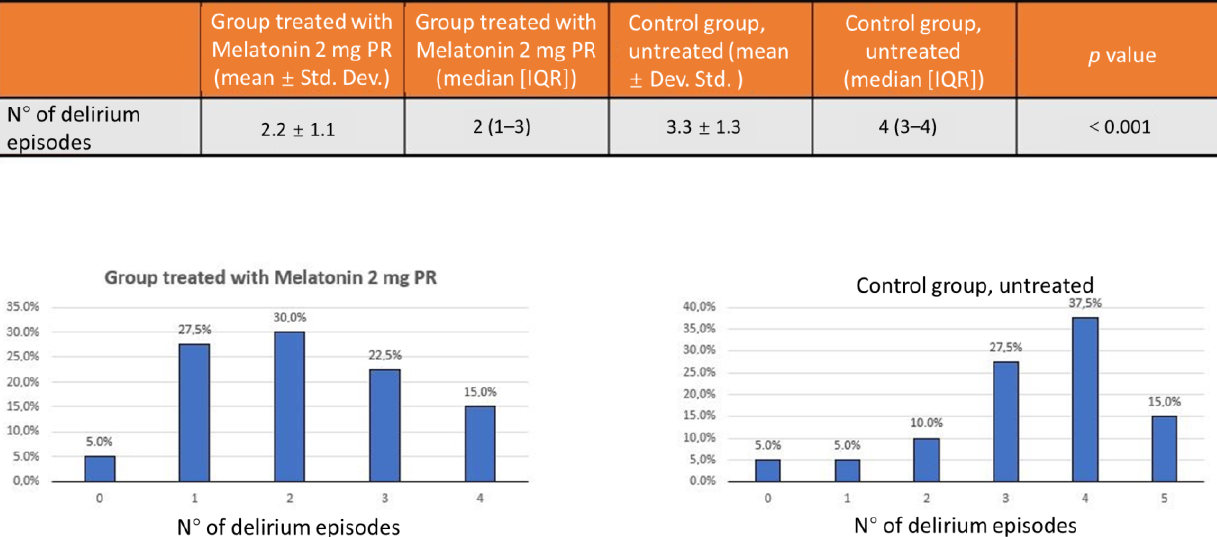
Figure 4. Number of patients transferred from sub-intensive to intensive care: in the group treated with PRM 2 mg, only 7.5% (figure 4a) versus 15% (figure 4c) of the un-treated group were transferred to intensive care due to clinical worsening, and 15% of the untreated group (figure 4d) died versus 7.5% of the treated group (Figure 4b).